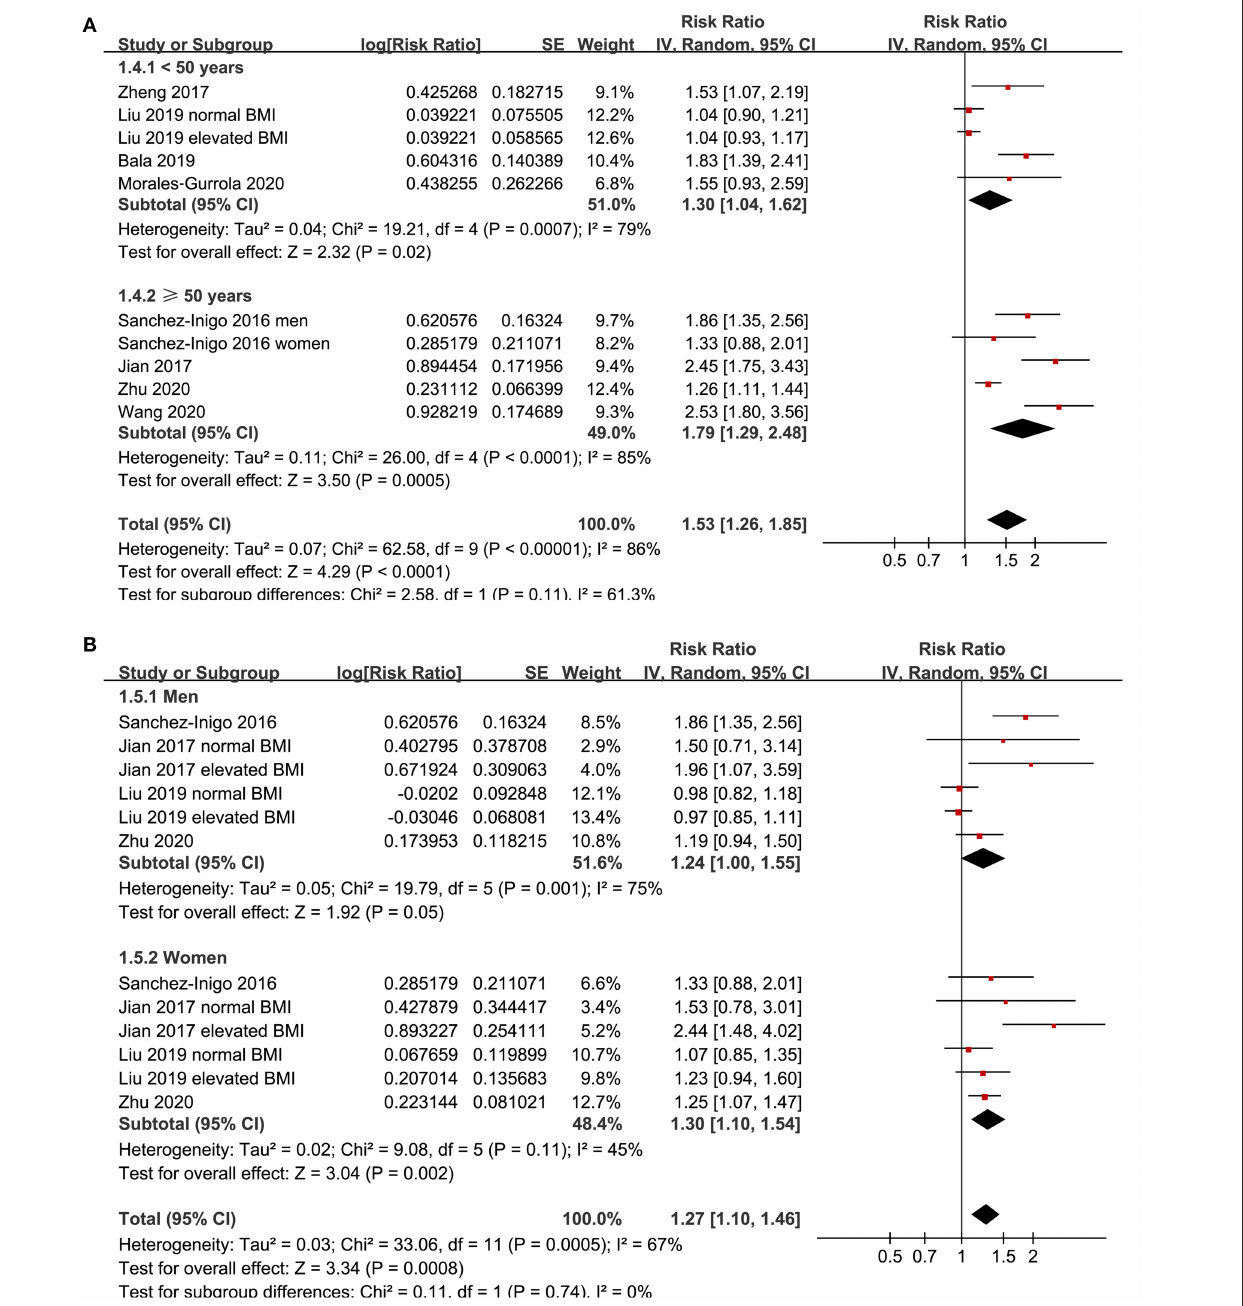
FIGURE 4 | Subgroup analyses for the association between TyG index and hypertension in community-derived adult population; (A) subgroup analysis according to the mean age of the population; and (B) subgroup analysis according to the gender of the